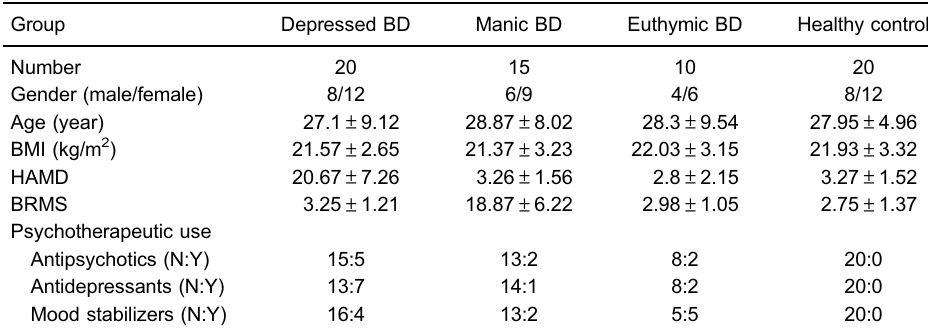
Table 1. Demographic and clinical characteristics of